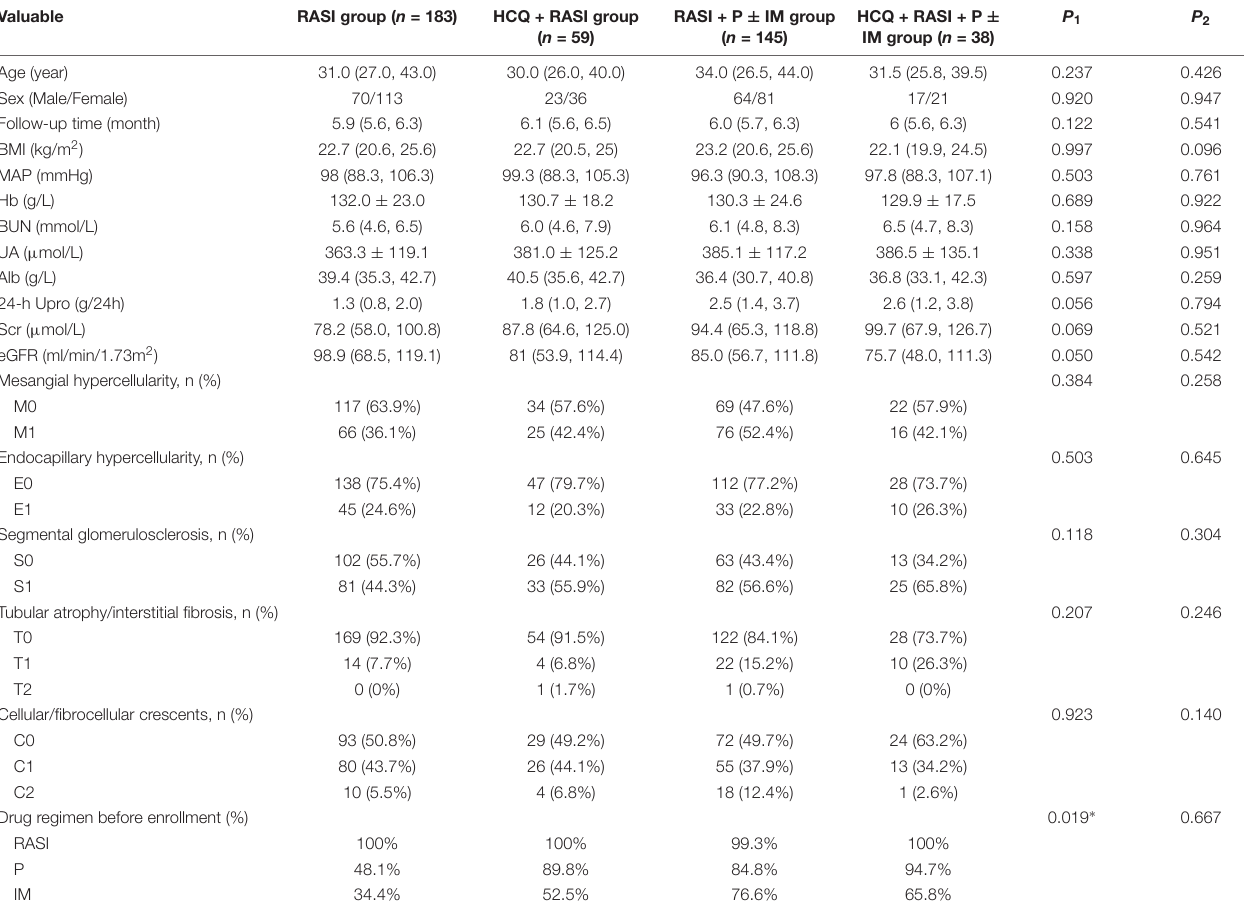
TABLE 1 | The clinicopathological characteristics of IgAN patients with residual proteinuria after at least 6 months of traditional treatment at renal biopsy. Valuable